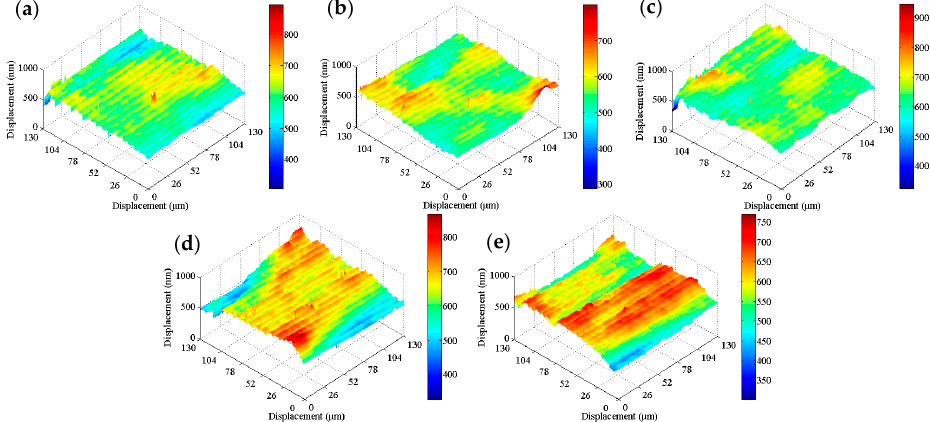
Figure 6. Geometrical topography images of ( a ) bright tin plating; ( b , c ) bright tin plating treated with chemical passivation for 3 s and 6 s, respectively; and ( d , e ) bright tin plating treated with electrolytic passivation for 3 s and 6 s, respectively. Table 2. Surface roughness ( R a , nm) of bright tin plating treated with different processes. Tinplate Sample